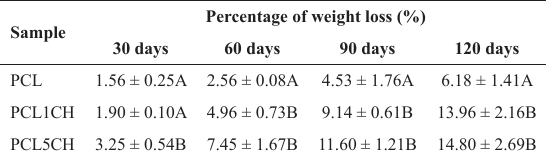
Table 3: Percentage of weight loss of films during the period of biodegradation.